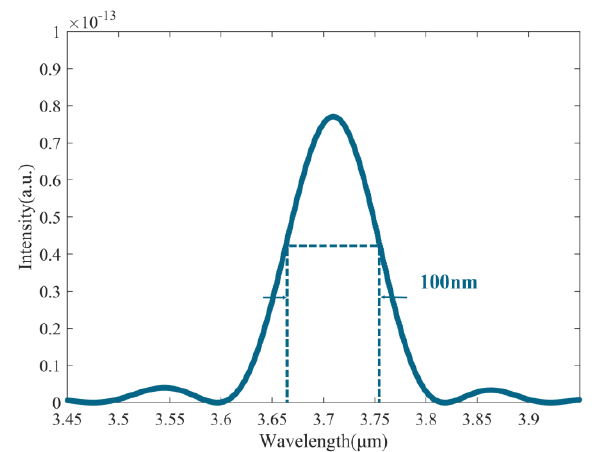
Figure 4. Simulated DFG idler spectrum.